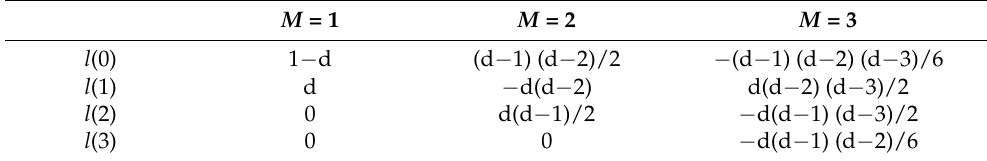
Table 1. The coefficients for the interpolation delay element.